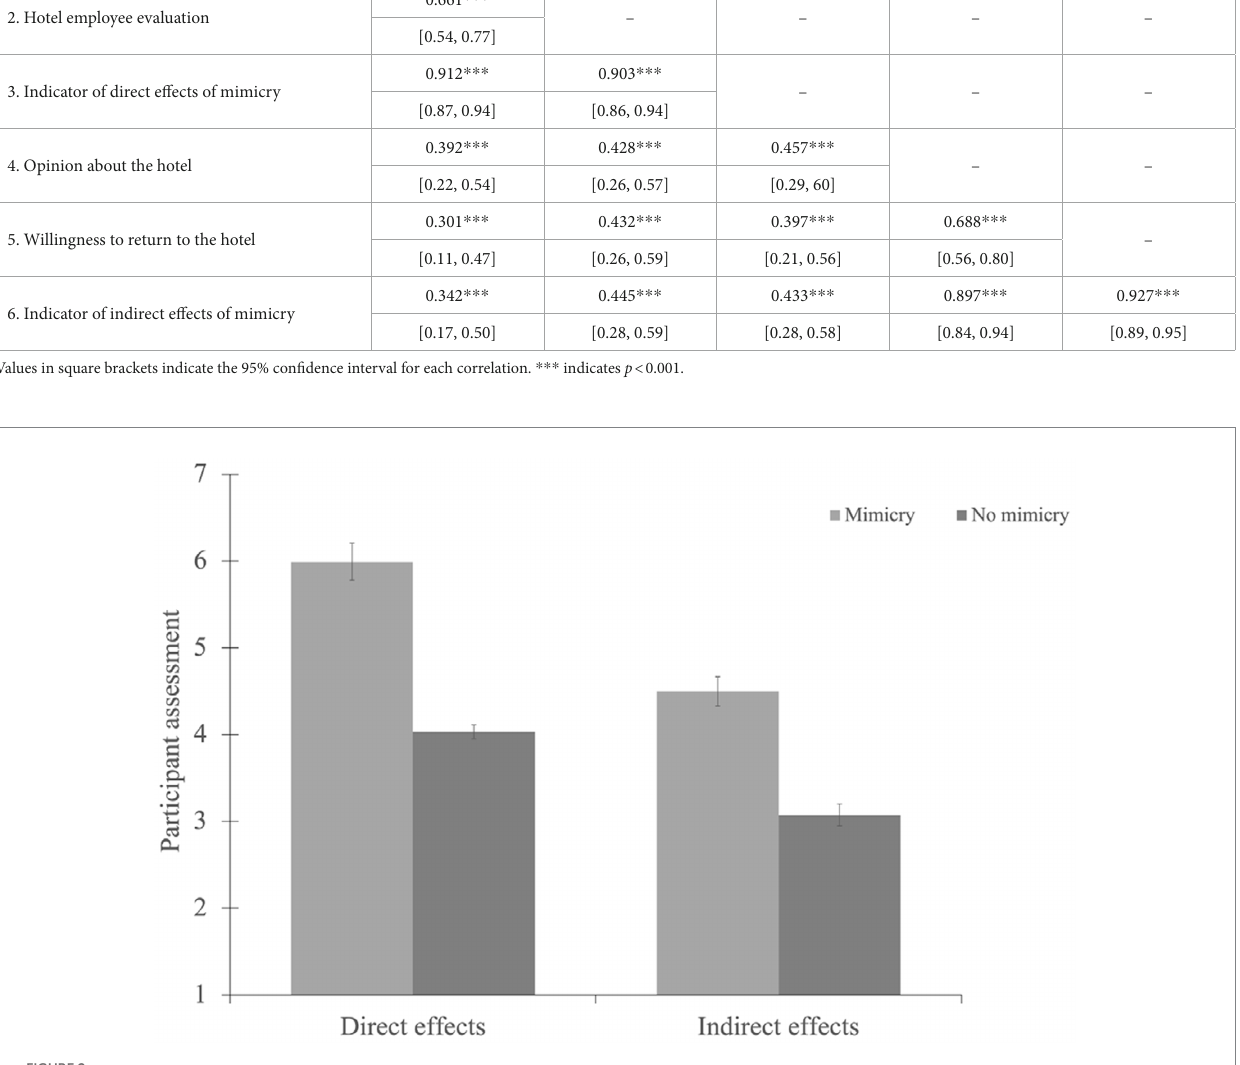
FIGURE 2 Participants evaluation in the Main Experiment as a function of experimental condition and directness. Bars represent mean values. Error bars represent standard errors of